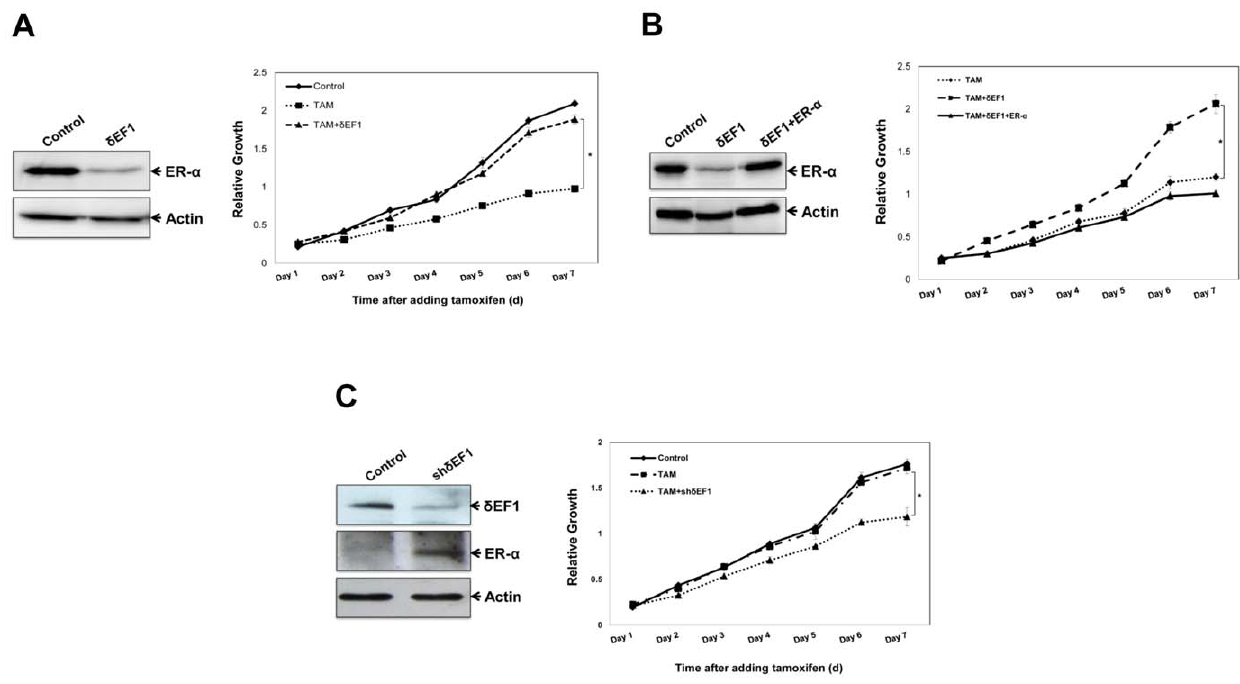
Figure 6. Ectopic expression of d EF1 decreases sensitivity of breast cancer cells to tamoxifen. A. MCF-7 cells were stably transfected with the d EF1 expression plasmid. The expression of the ER- a protein was determined using Western Blot. Actin was used to normalize the ER- a level. MCF-7 cells stably transfected with d EF1 were treated with 10 2 6 M tamoxifen. At the indicated time points, cell growth was measured using the CCK- 8 assay. * indicates p , 0.05 in unpaired Student’s t-test compared with the control. B. ER- a expression plasmid was introduced into MCF-7 cells that were stably transfected with d EF1 followed by treatment with tamoxifen (10 2 6 M). The ER- a protein expression was determined using Western Blot. Actin was used to normalize the ER- a level. At the indicated time points, the cell growth was assessed using the CCK-8 assay. * indicates p , 0.05 in unpaired Student’s t-test compared with control. C. MDA-MB-231 cells were stably transfected with shRNA targeting d EF1. The expressions of d EF1 and ER- a protein were determined using Western Blot. Actin was used to normalize the ER- a level. MDA-MB-231 cells stably transfected with sh d EF1 were treated with 10 2 6 M tamoxifen. At the indicated time points, cell growth was measured using the CCK-8 assay. * indicates p , 0.05 in unpaired Student’s t-test compared with the